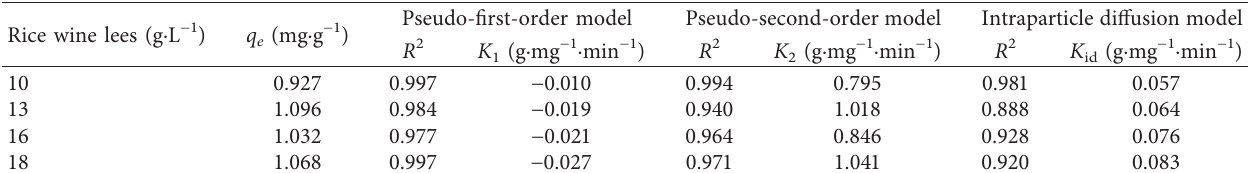
Table 3: Kinetic parameters for the adsorption of acid red 73 on the rice wine lees.